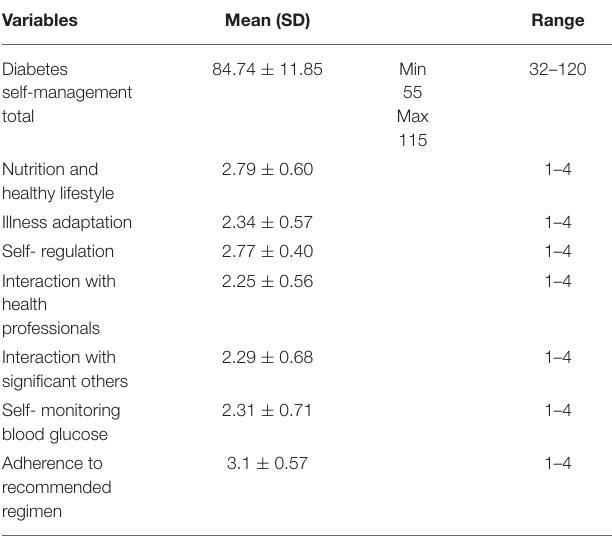
TABLE 2 | Descriptive table of diabetes self-management ( n =